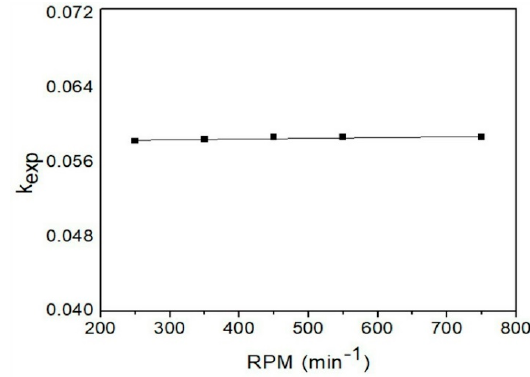
Figure 13. Dependence of ln k exp vs temperature. Calculated activation energy, Ea = 43.5 kJ ∙ mol − 1 .